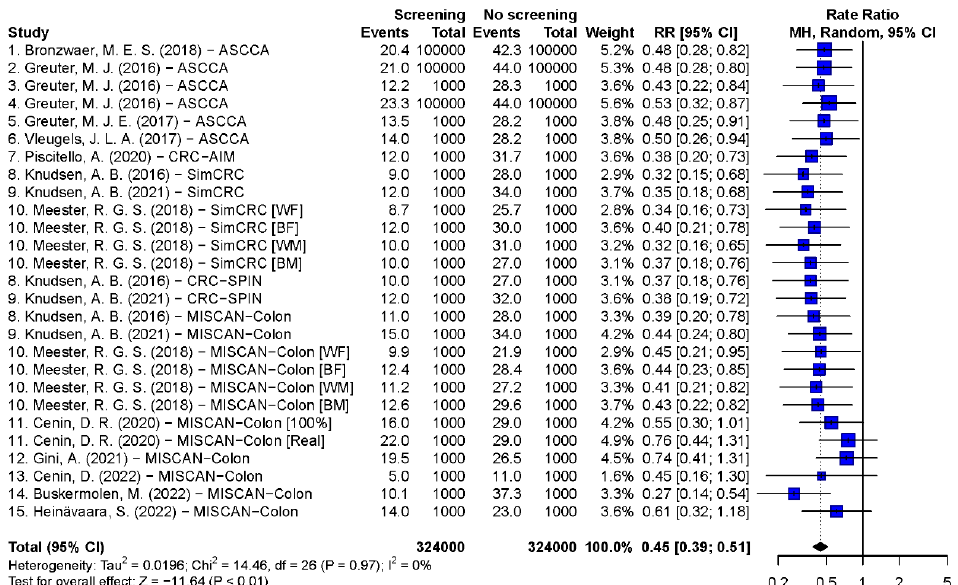
Figure 2. Forest plots of the CRC-speci fi c mortality rate ratio on biennial FIT screening from the age of 55 to 75 [12,19,22,26–28,30,31,36,40,43,59,60,62,63].